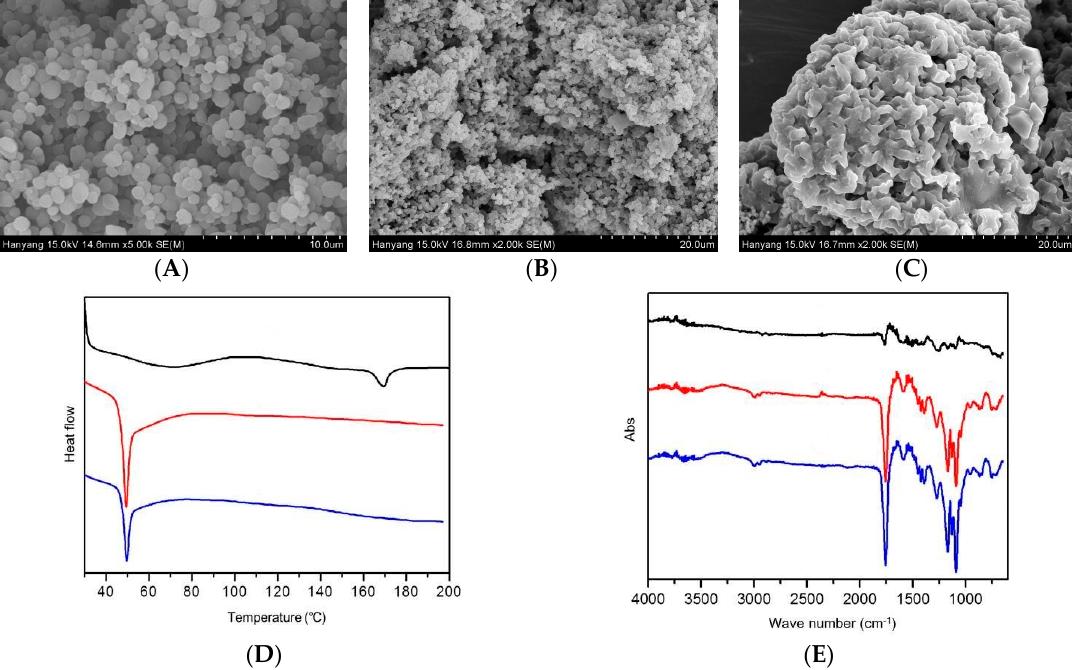
Figure 3. Physicochemical properties of electrosprayed microspheres. Scanning electron micrographs of electrosprayed microspheres ( A ) and after one day ( B ) and 28 days ( C ) in release buffer. Differential scanning calorimetry thermograms of leuprolide (black line), poly ( d , l -lactide-co-glycolide) (PLGA) (red line), and electrosprayed microspheres (blue line) ( D ). Fourier transform infrared spectroscopy spectra of leuprolide (black line), PLGA (red line), and electrosprayed microspheres (blue line) ( E ). The DSC thermograms of leuprolide, PLGA, and electrosprayed microspheres are illustrated